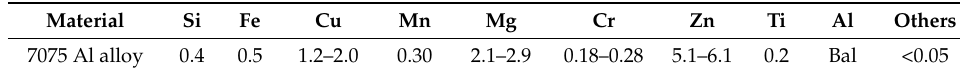
Table 1. Chemical composition of 7075 Al alloy substrate.